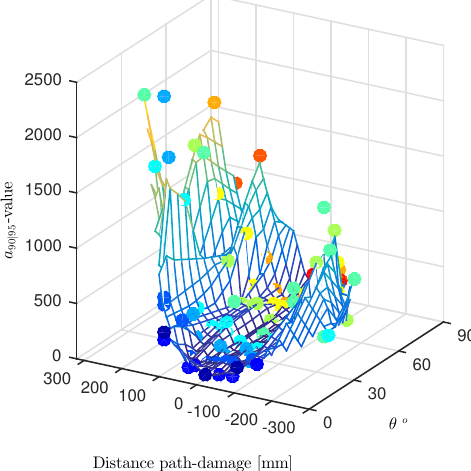
Figure 17. Interpolating surface of a 90 | 95 values versus path-damage distance and incidence angle ( θ ) from the flaw. The POD ( a ) is predicted along all through the paths crossing the